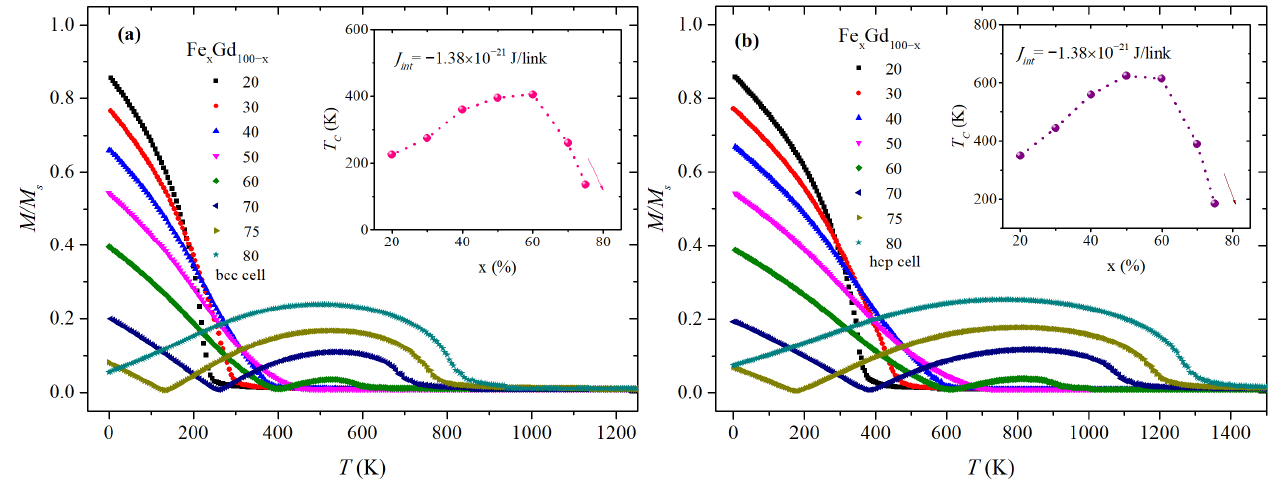
Figure 3. Simulations of temperature-dependent normalized magnetization of the Fe x Gd 100 − x alloys with antiferromagnetic exchange interactions for the bcc ( a ) and hcp ( b ) structures for the value of exchange interaction J Fe − Gd = − 1.380 × 10 − 21 J/link. The insets of the figures show the concentration dependence of the critical temperature, determined from the corresponding M(T) curves.